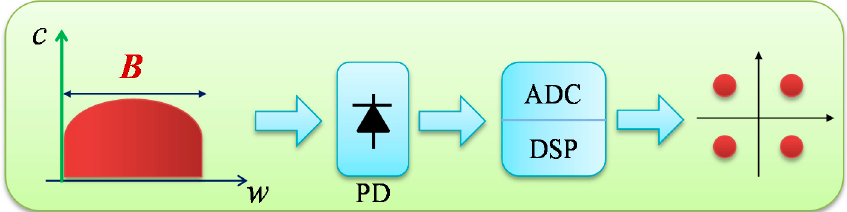
Figure 5. Kramers-Kronig direct detection scheme; PD: photodetector; ADC: analog to digital converter; DSP: digital signal processing module.